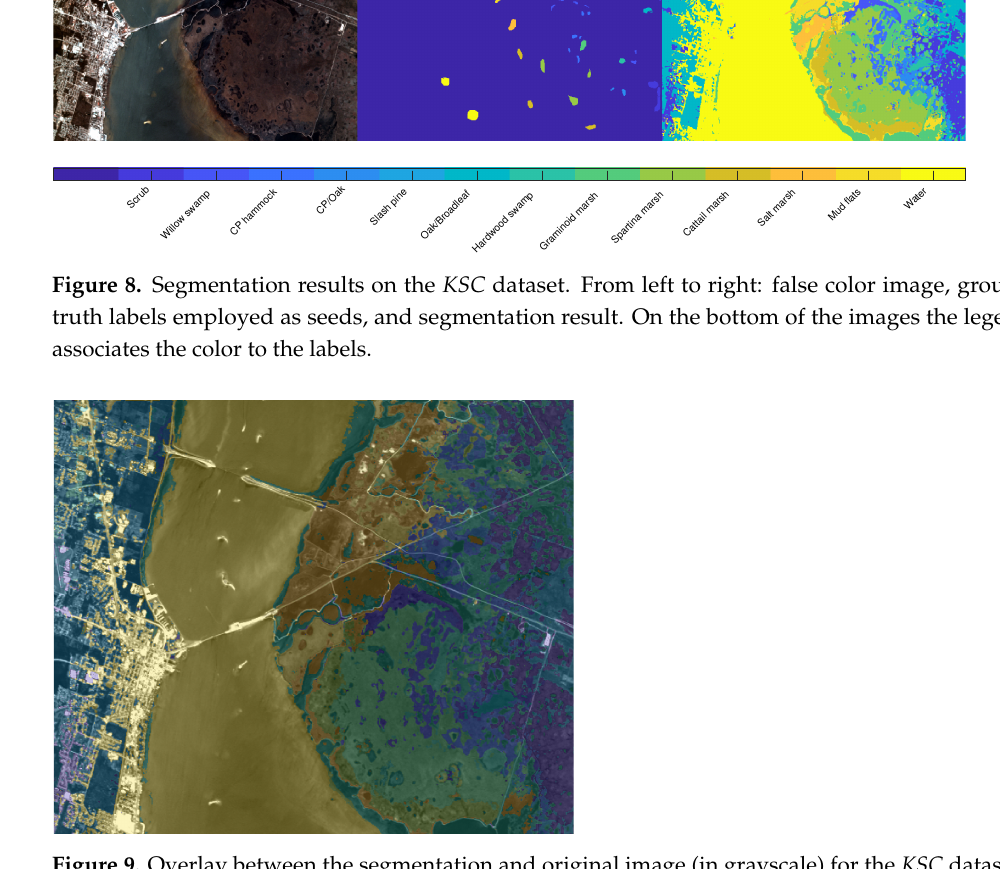
Figure 9. Overlay between the segmentation and original image (in grayscale) for the KSC